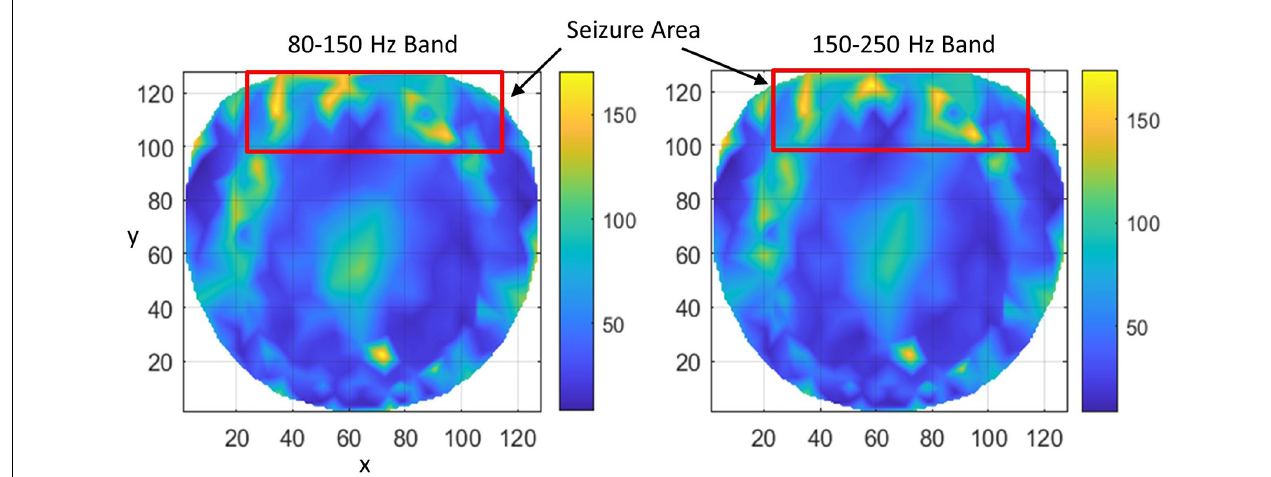
FIGURE 5 | The rate of formation (counts/s) of stable phase cone clusters averaged over a 240-s interictal period for subject #3 in the 80–150 and 150–250 Hz bands are given in the left and right plots, respectively. The color bar indicates the rate in counts/s. The seizure activity area is marked with a red rectangle which shows several hot spots.